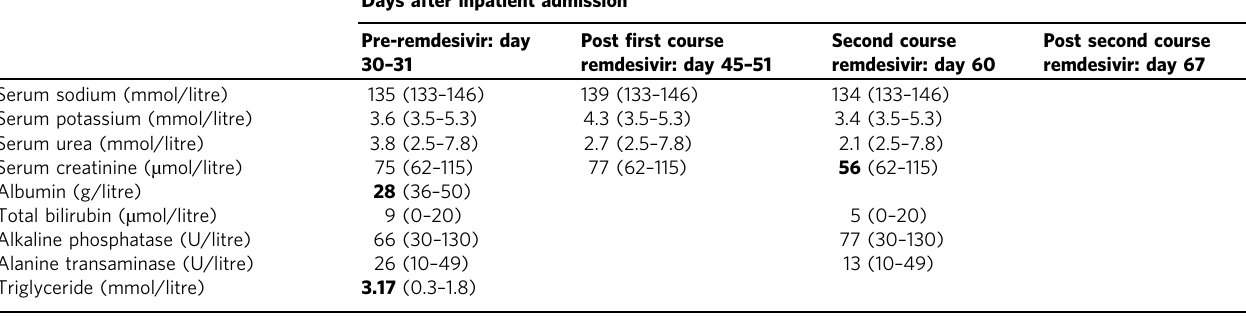
Abnormal results are shown in bold. Numbers in parentheses indicate reference values of the corresponding measurements.